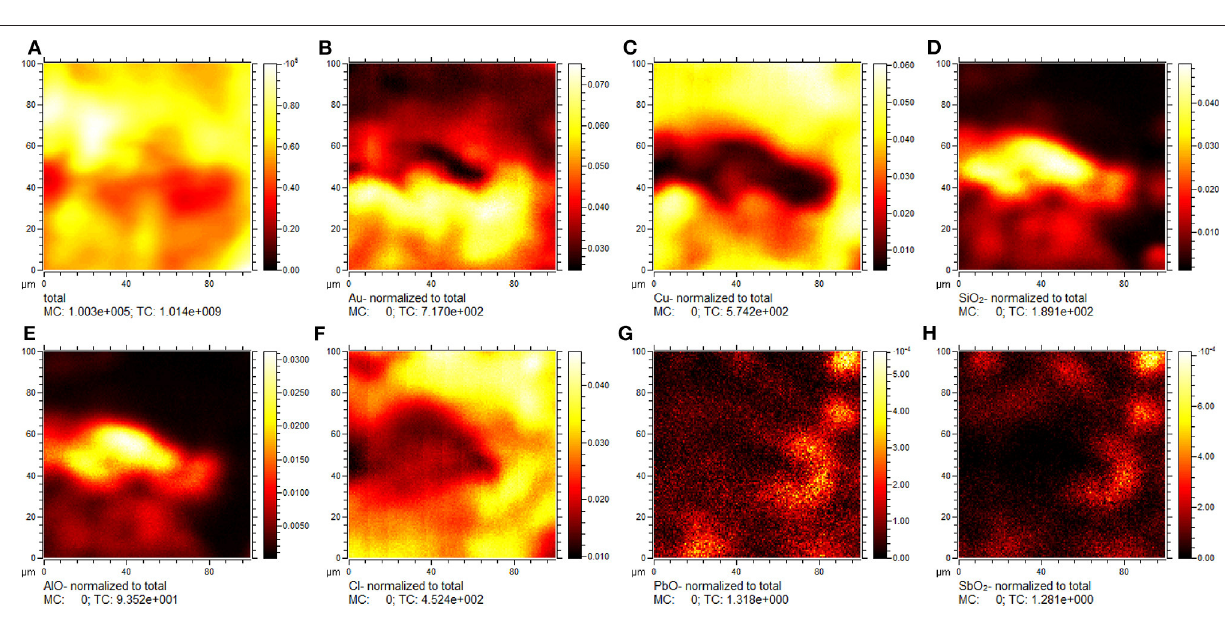
FIGURE 3 | ToF-SIMS negative ion chemical maps showing the distribution of selected species on the analyzed sample surface: (A) total ion intensity; (B) Au − ; (C) Cu − ; (D) SiO − 2 ; (E) AlO − ; (F) Cl − ; (G) PbO − ; (H) SbO − 2 . Signal ion intensity in figures (B–H) is normalized to the total ion